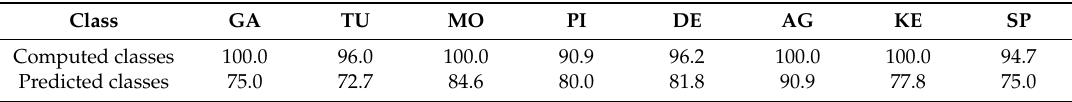
Table 3. Proportion (%) of correctly classified potato samples using PLS-DA in the calibration (computed classes) and external prediction (predicted